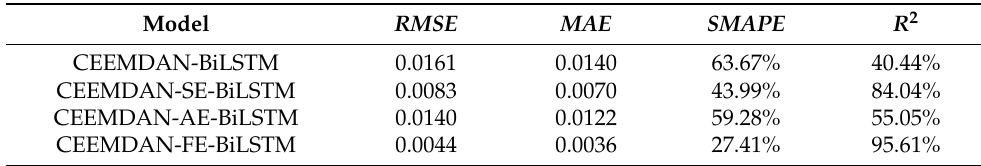
Table 5. Prediction error of O 3 concentration prediction